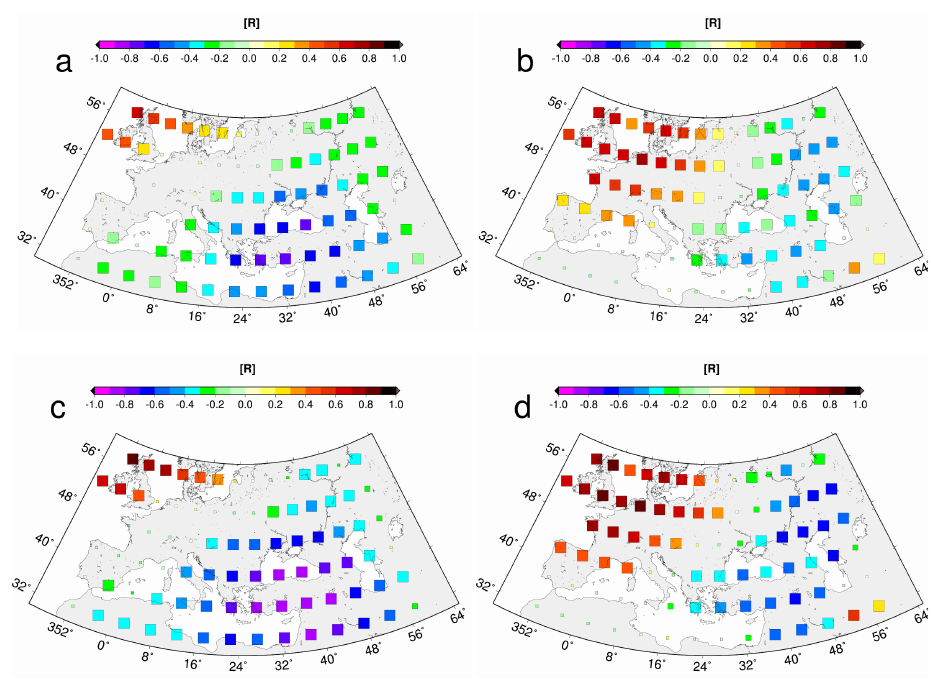
Fig. 3. Correlation coefficients between temperature and NCPI for all cases, in December-January-February (a) ; in June-July-August (b) ; only for | NCPI | > 1 . 0, in December-January-February (c) and in June-July-August (d) . Squares’ sizes are relative to the significance level (large squares, p < 0 . 01; medium squares, p < 0 . 05; small squares, p > 0 .